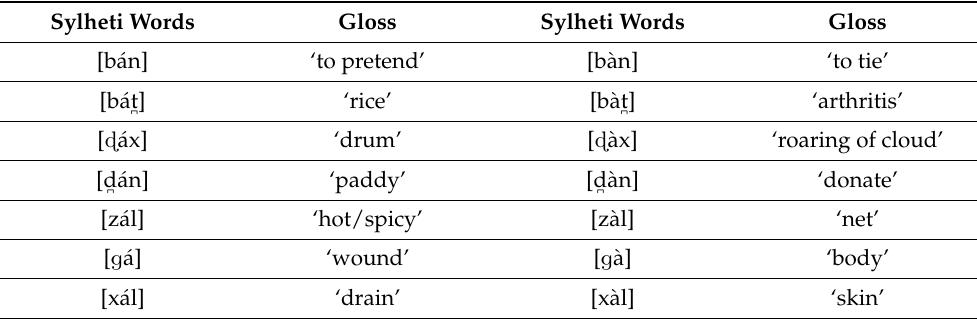
Table 1. Dataset displaying the list of monosyllabic words considered in this work. Sylheti